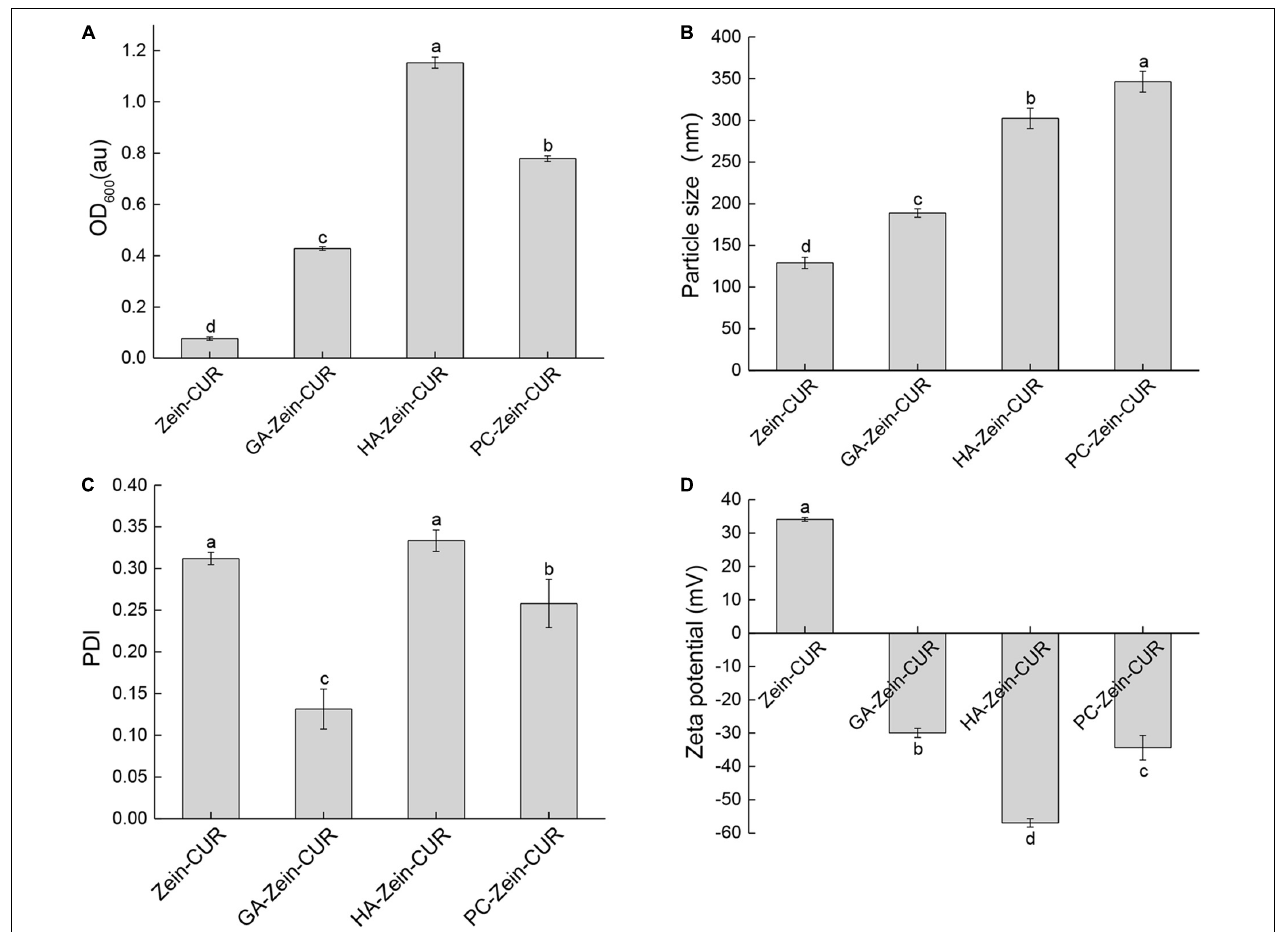
FIGURE 2 | Analysis of zein-curcumin (CUR) and polysaccharide (PS)-Zein-CUR suspensions. (A) Turbidity (OD 600 ), (B) particle size, (C) polydispersity index (PDI), and (D) zeta potential. Values are mean ± SD, n = 3. Bars marked with different letters indicate significant difference at P < 0.05.